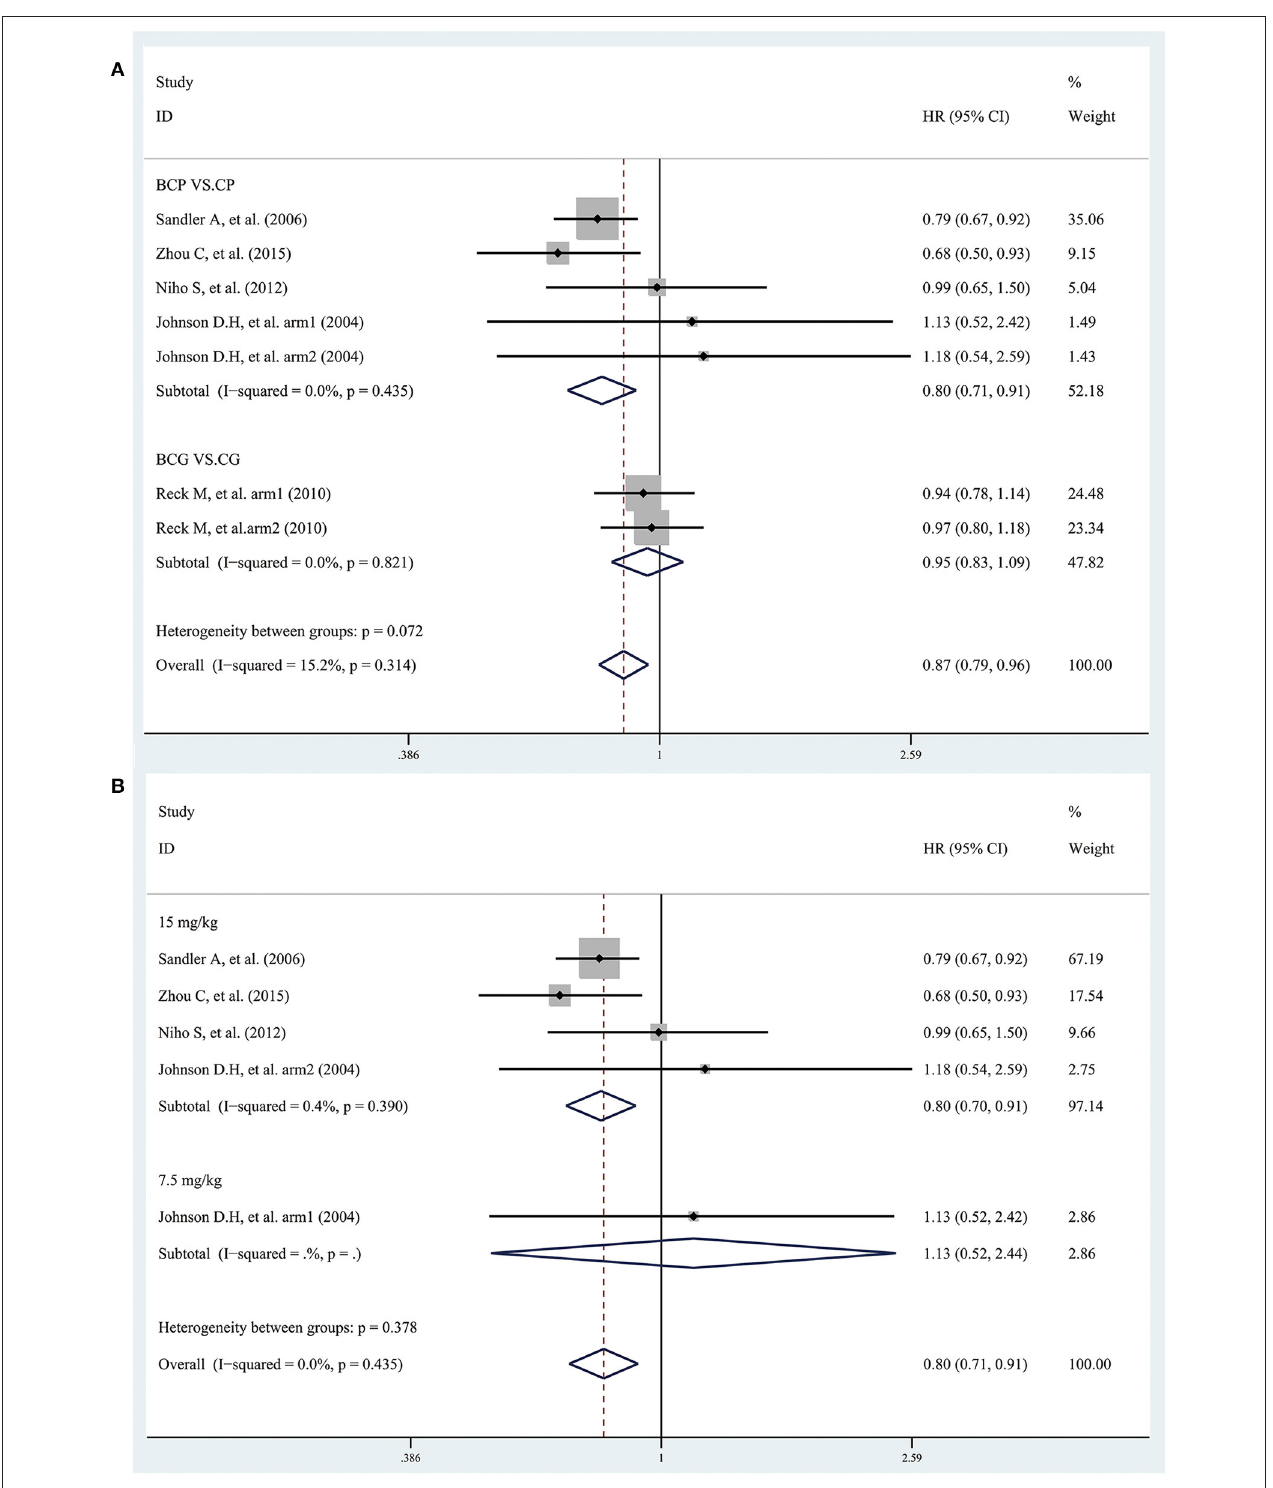
FIGURE 3 | Forest plots of hazard ratios (HRs) for overall survival (OS) based on (A) treatment and (B) bevacizumab dose (7.5 mg/kg and 15 mg/kg) from randomized controlled trials of bevacizumab added to standard chemotherapy, compared with chemotherapy alone, as first-line therapy in patients with advanced NSCLC.